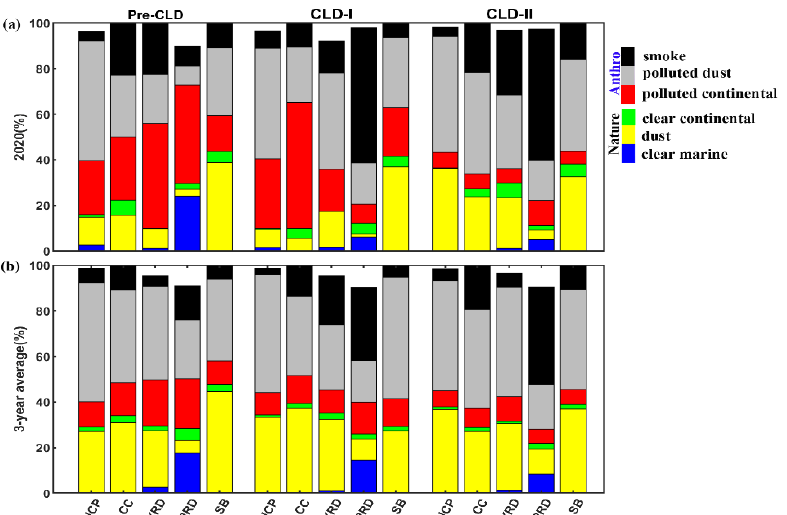
Figure 11. ( a ) Occurrence frequencies of each aerosol subtype contributed to the total aerosol type in the vertical direction for five study areas during Pre-CLD, CLD-I, and CLD-II periods, and ( b ) the same window contribution data in previous